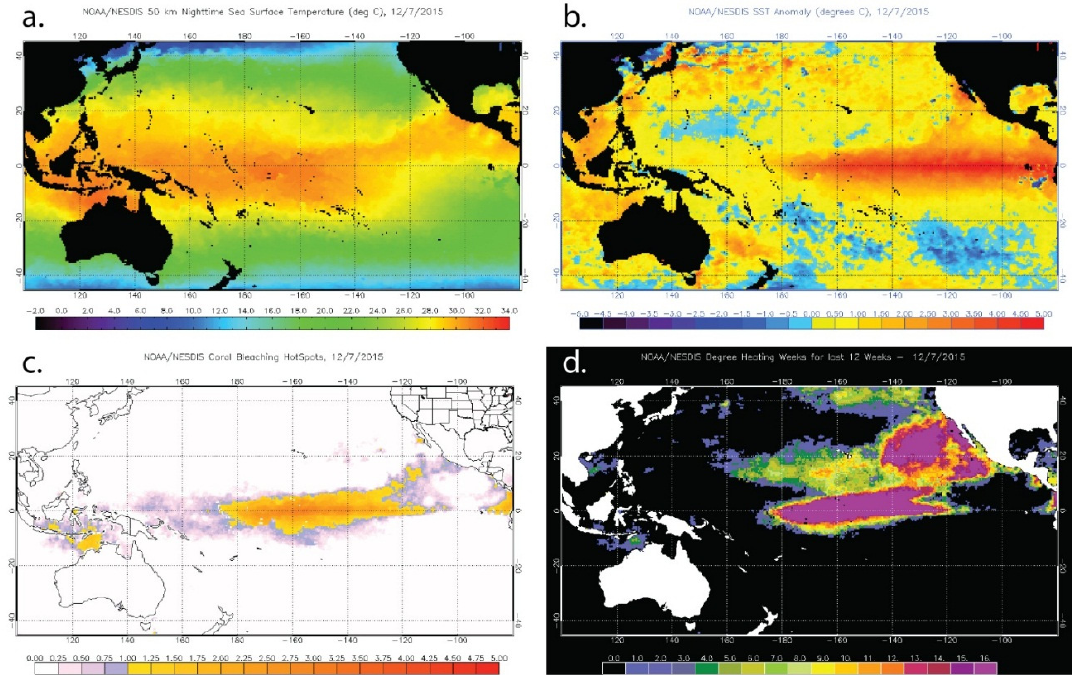
Figure 4 . Examples of the U.S. National Oceanic and Atmospheric Administration (NOAA) Coral Reef Watch products for 12 October 2015, a time at which coral bleaching has been reported in Hawaii. ( a ) Sea Surface Temperature; ( b ) Sea Surface Temperature Anomaly; ( c ) HotSpot; and ( d ) Degree Heating Weeks.